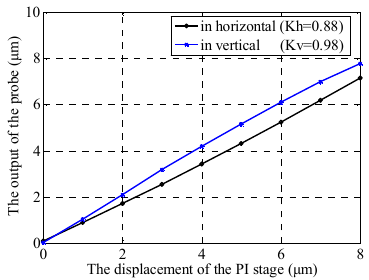
Figure 10. The sensitivity and permissible range of the probe.